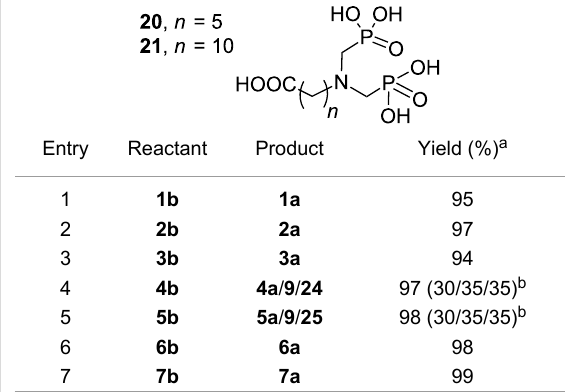
Table 1: Deprotection of phosphonates 1b – 7b obtained with the following conditions: 1) TMSBr, CHCl 3 , RT, 16 h; 2) MeOH, RT, 2 h.